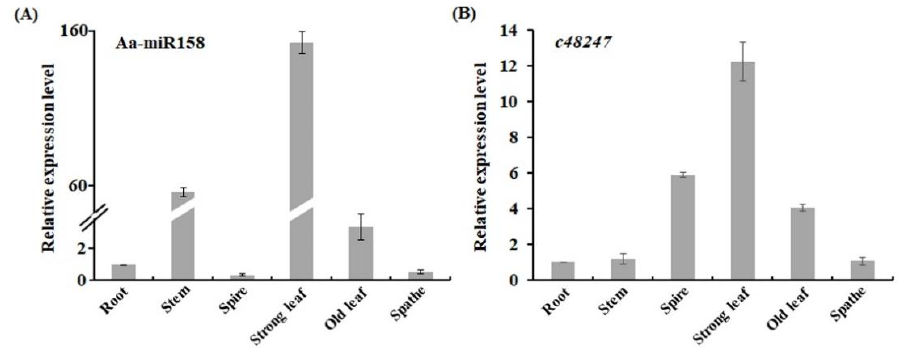
Figure 2. Expression patterns of Aa-miR158 ( A ) and c48247 ( B ) in different organs of A. andraeanum . Error bars represent standard deviations ( n = 3). Error bars represent standard deviations ( n =